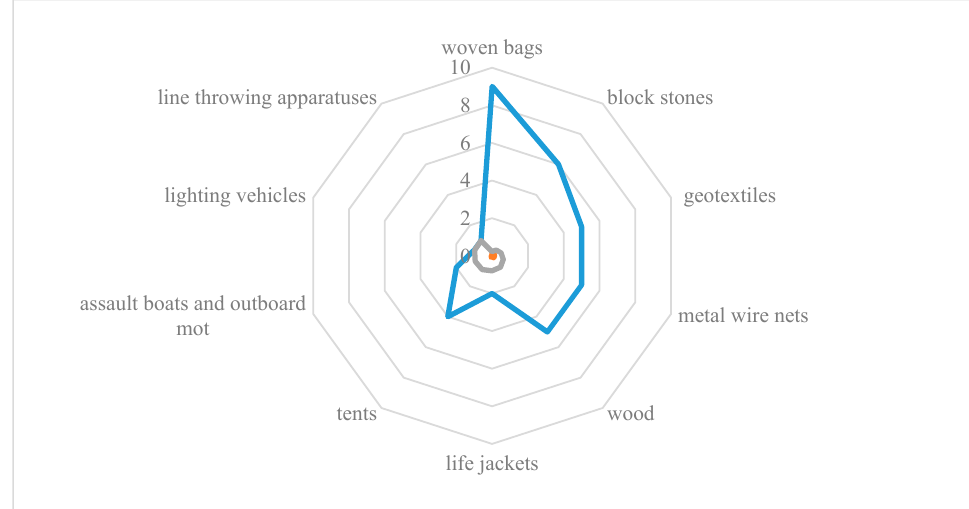
Figure 3. The utilisation frequency of the 12 classes of Jiangsu provincial-level flood control materials.